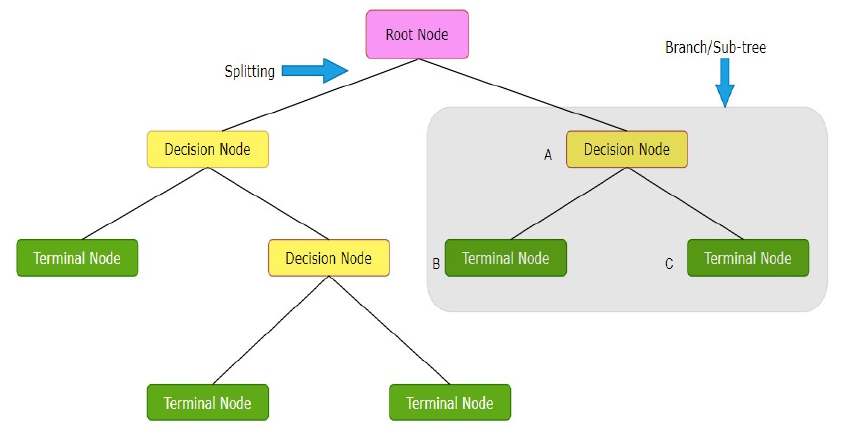
Figure 3. Model Diagram for Decision Tree Algorithm. Table 3. Different attribute selection types for DTA.